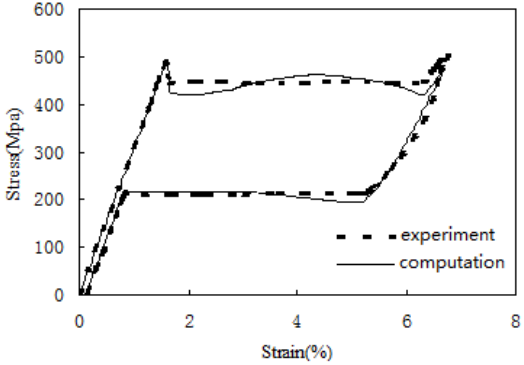
Figure 4. The nominal tensile stress–strain curve of